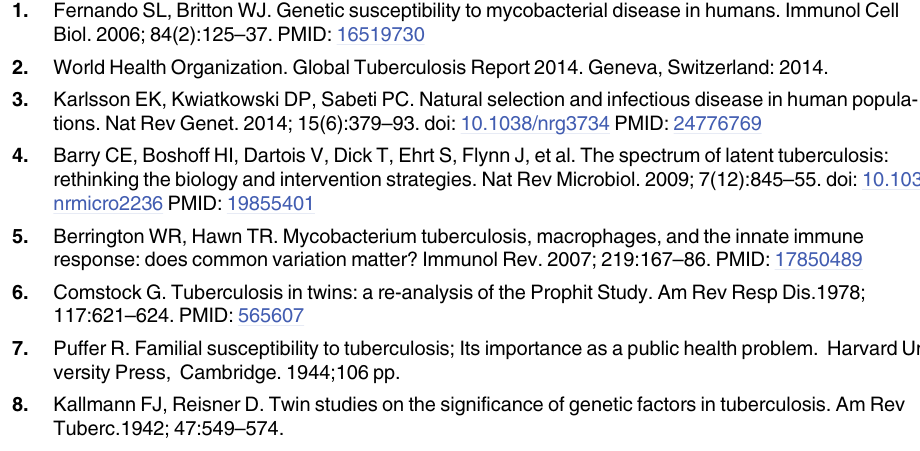
S3 Table. Allelic and Genotypic Frequencies for Cytokine SNPs in Pulmonary Tuberculosis